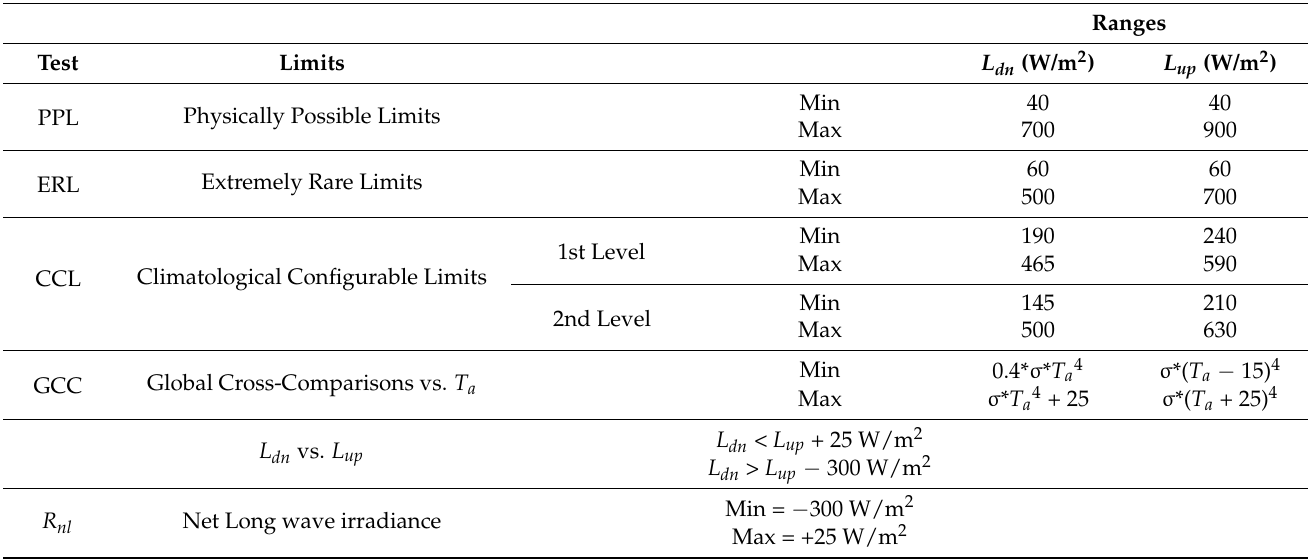
Table 2. Physically possible and extremely rare global limits recommended by BSRN and user configurable climatological limits, as well as global cross-comparisons based on air temperature ( T a ) (in Kelvin) and between the two longwave variables. σ is the Stefan–Boltzman constant = 5.67 × 10 − 8 Wm − 2 K − 4